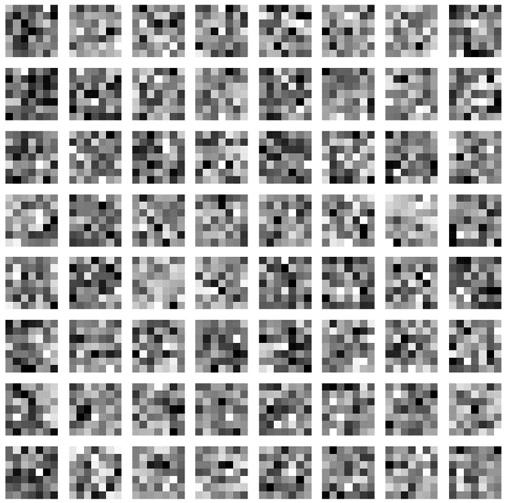
Figure 14. Filter visualization results.